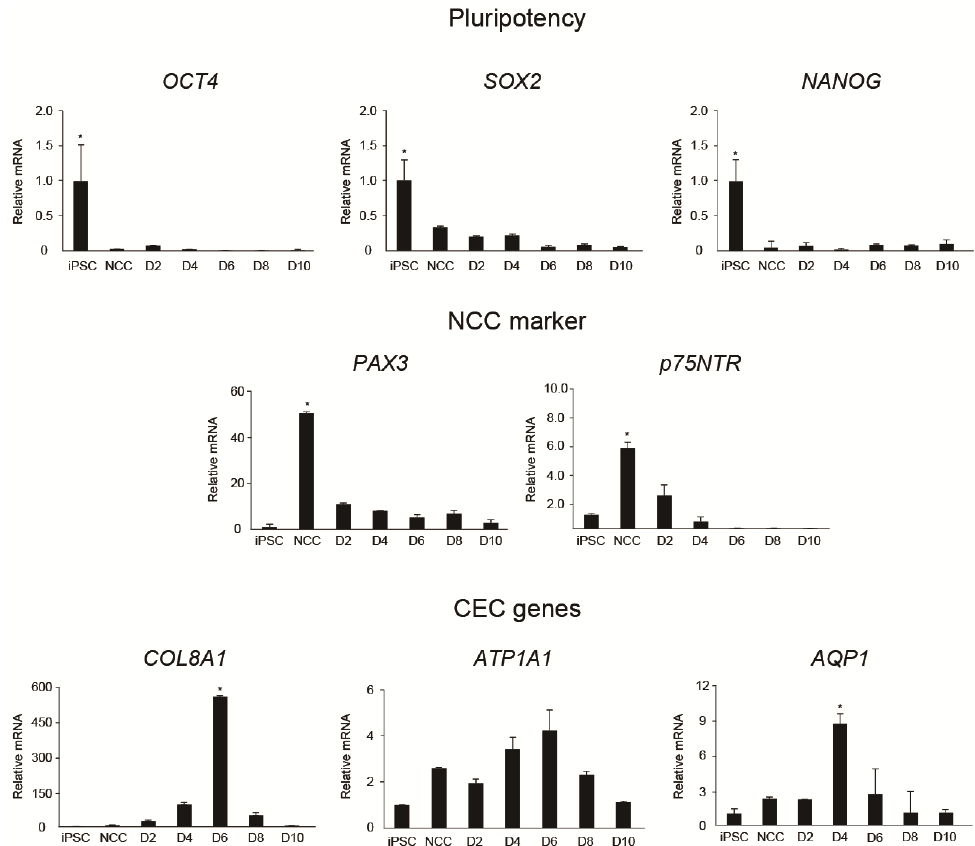
Figure 2. Quantitative real-time RT-PCR (qRT-PCR). qRT-PCR analysis of the expression of repre- sentative pluripotent stem cell (PSC), neural crest cell (NCC), and corneal endothelial cell (CEC) genes. NCC-related gene expression decreased as differentiation progressed, while CEC-related gene expression increased until 6 days after CEC differentiation, decreasing thereafter (* p < 0.05).